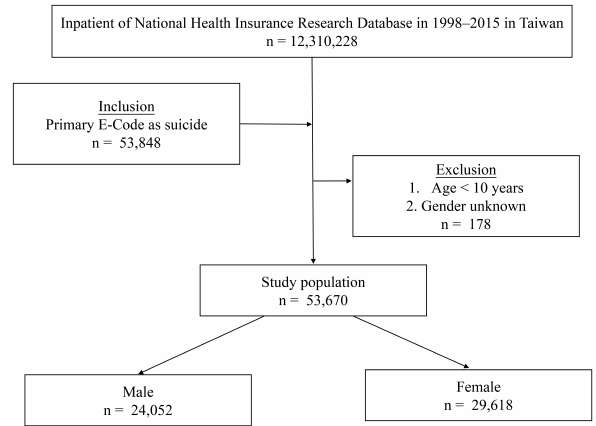
Fig. 1. Research flow